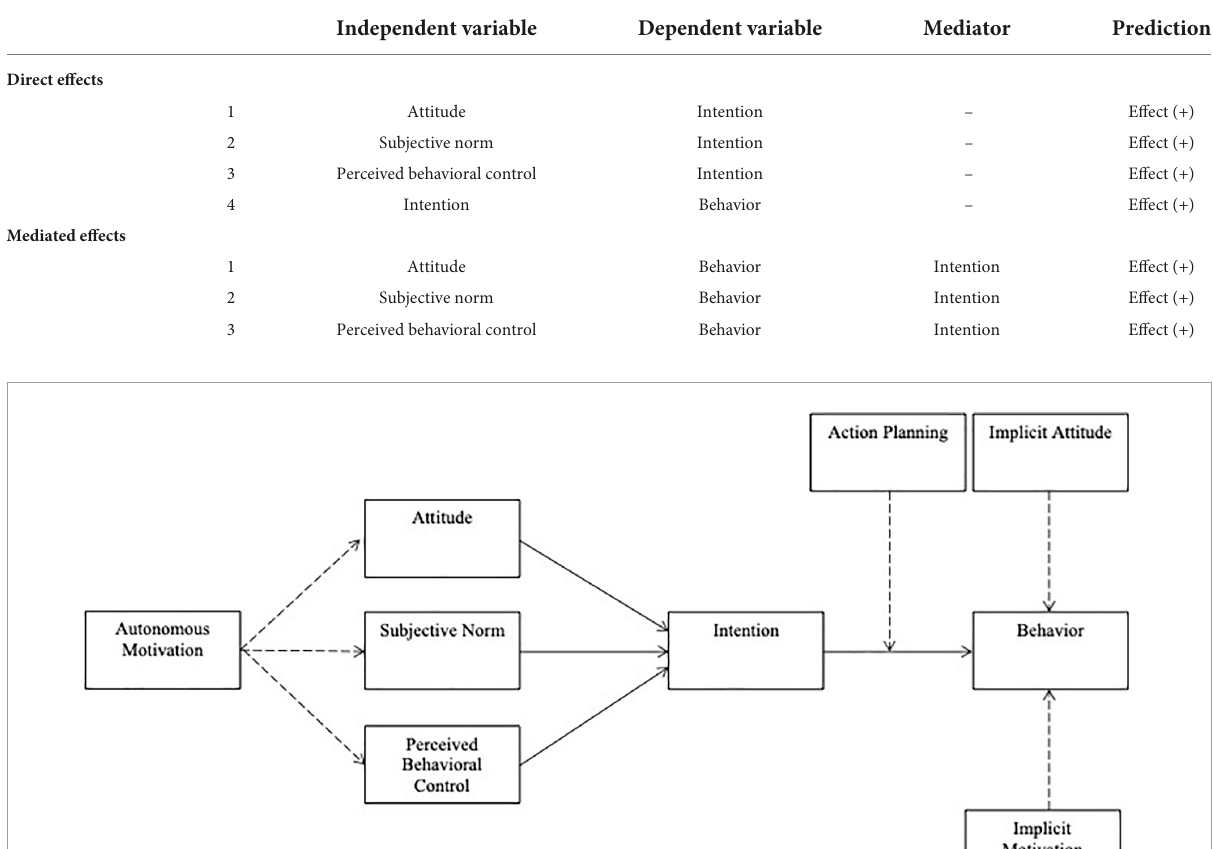
TABLE 1 Theory of Planned Behavior predictions for positive health behaviors.